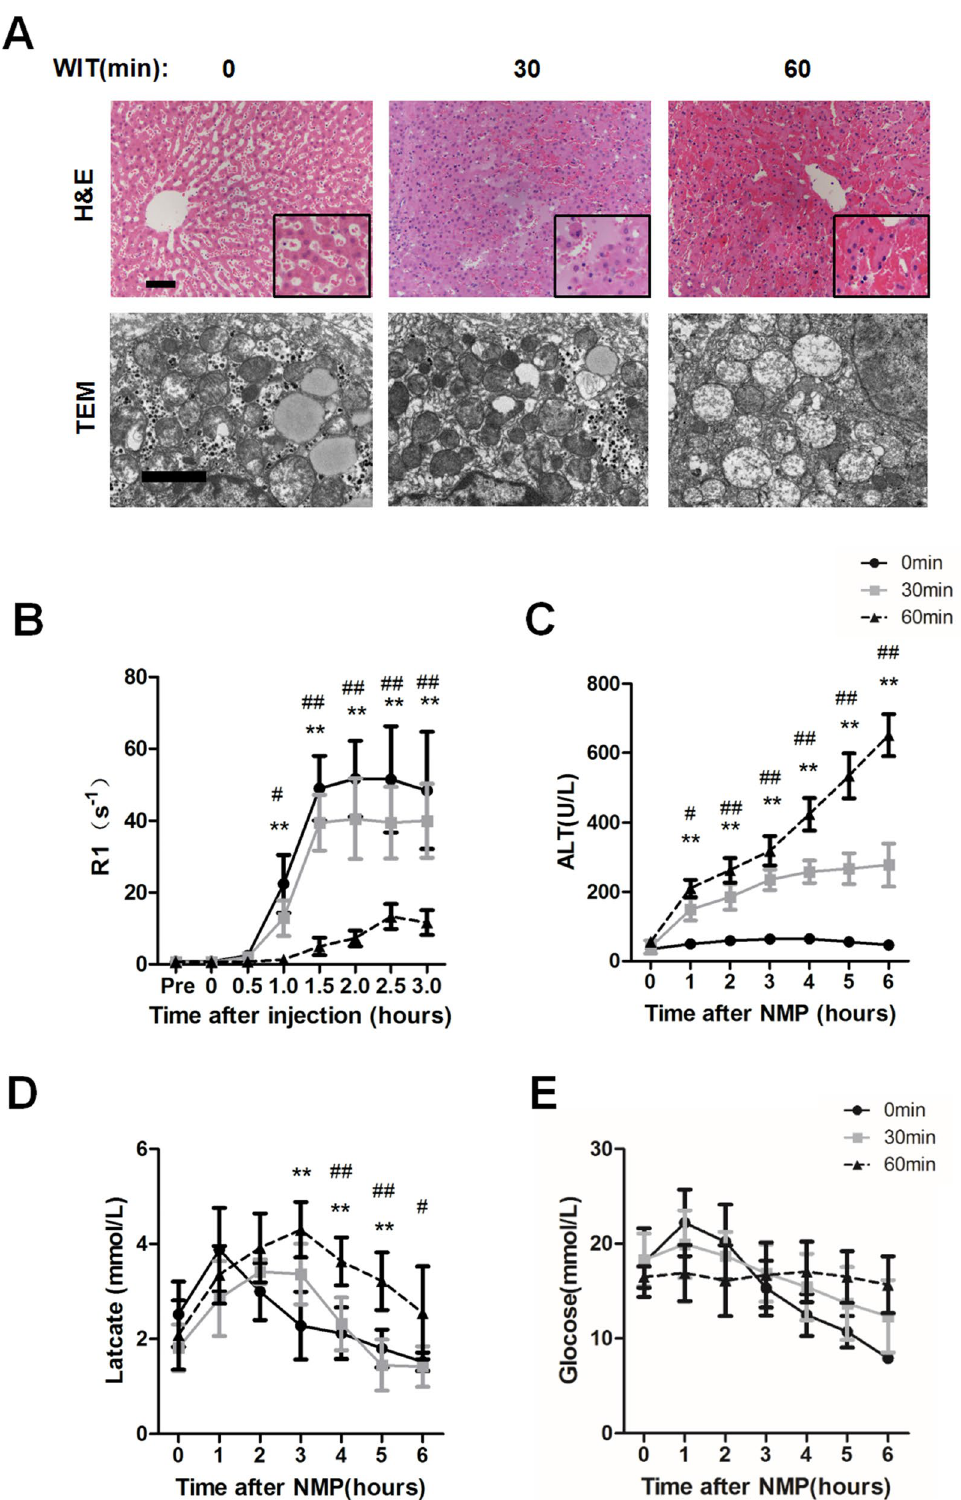
Figure 2. Detection of biliary R1 and biochemical parameters in DCD livers with different WIT during NMP. ( A ) Histological (top) and transmission electron microscopy (TEM) (bottom) images of hepatocytes were obtained from the indicated groups 6 h after NMP initiation. The scale bars in the histological and TEM images represent 100 μm and 2 μm, respectively. ( B – E ) Evaluation of biliary R1, ALT, perfusate lactate, and perfusate glucose levels of grafts receiving different warm ischemia time. Grafts were divided into three groups according to the warm ischemia time (a. 0 ′ ; b. 30 ′ ; c. 60 ′ ). After cannulating to identical NMP, bile and blood samples were collected at the indicated time points (data represent mean ± SD. Two-way ANOVA was used for the analysis of differences among three groups. Group a (0 ′ ) vs. Group c (60 ′ ): * P < 0.05, ** P < 0.01; Group b (30 ′ ) vs. Group c (60 ′ ): # P < 0.05, ## P <